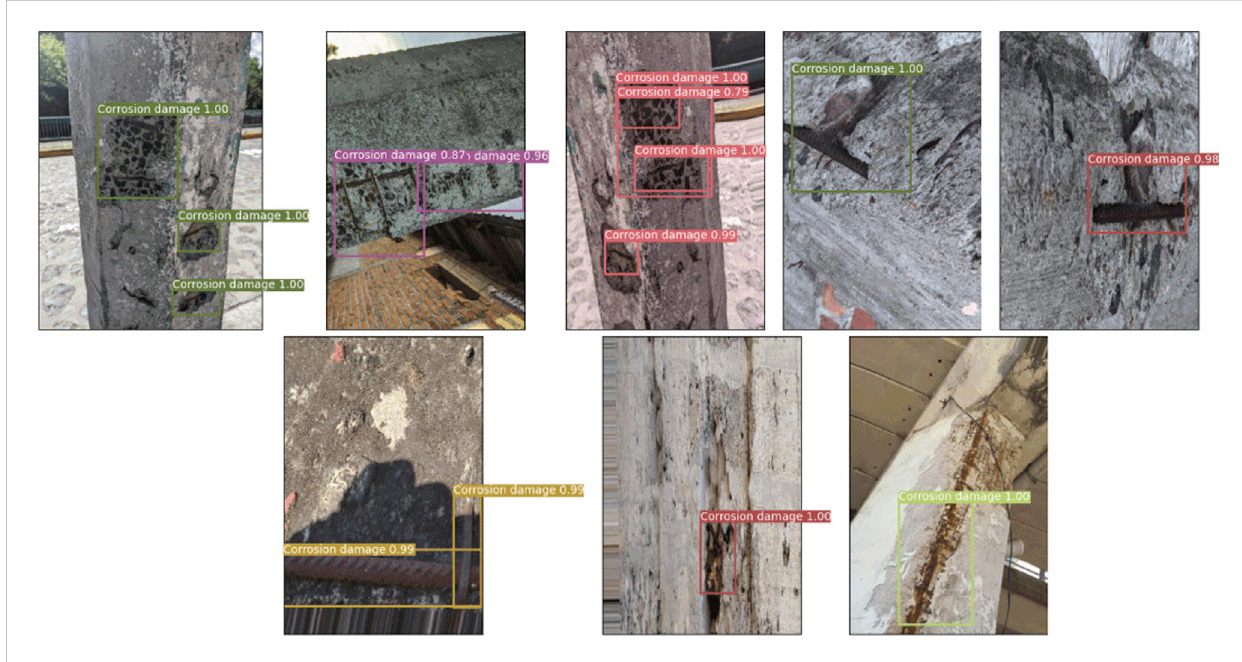
FIGURE 13 Corrosion damage localization on concrete structures using the built detector.